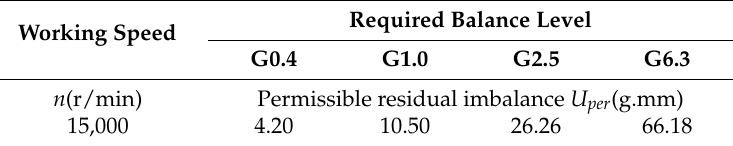
Table 2. Permissible residual unbalance of the rotor